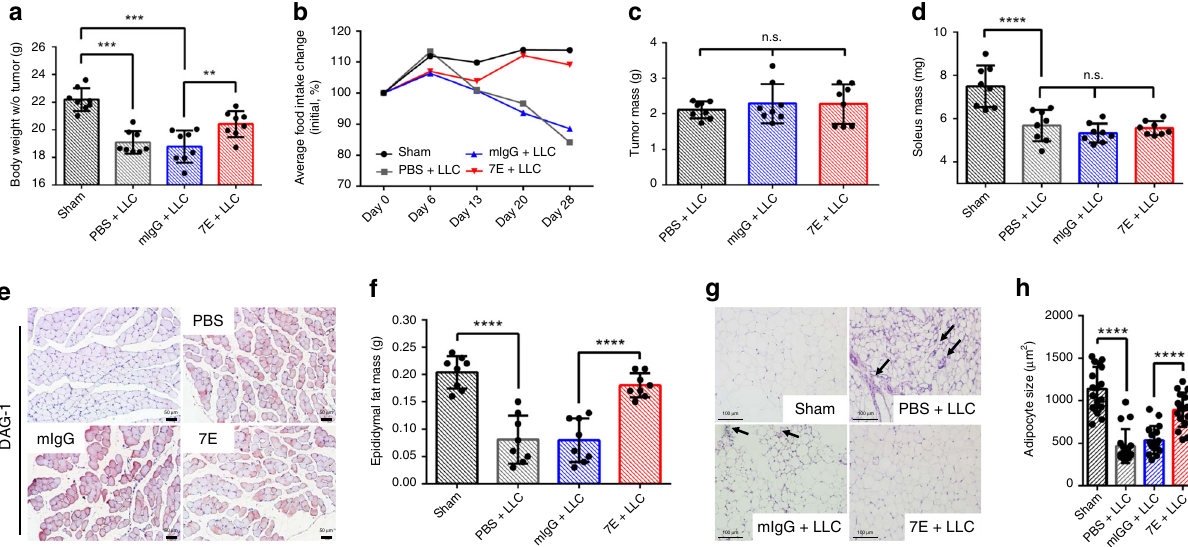
Fig. 6 7E treatment alleviated LLC tumor-induced cachexia symptoms in mice. LLC tumor-bearing mice were injected (i.p.) with PBS, mIgG, or 7E ( n = 8) twice per week throughout the study. Sham controls ( n = 8) were not injected with cancer cells. a The tumor-free body weight of the mice was measured on day 28. One-way ANOVA, p < 0.0001; ** p < 0.01, *** p < 0.001. b The average food intake of the mice was monitored every week. c Tumors were collected and weighed on posttreatment day 28. One-way ANOVA, p = 0.7059. d The soleus muscles were excised and weighed. One-way ANOVA,